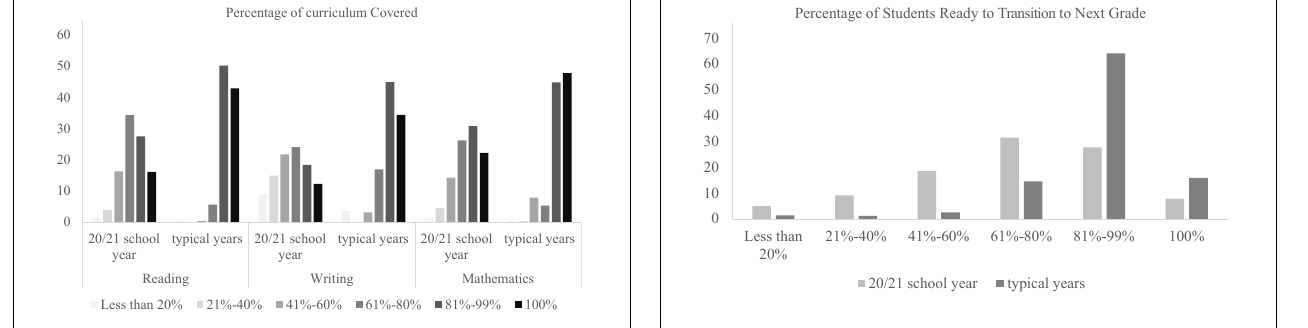
FIGURE 2 | Percentage of curriculum covered in each academic area.